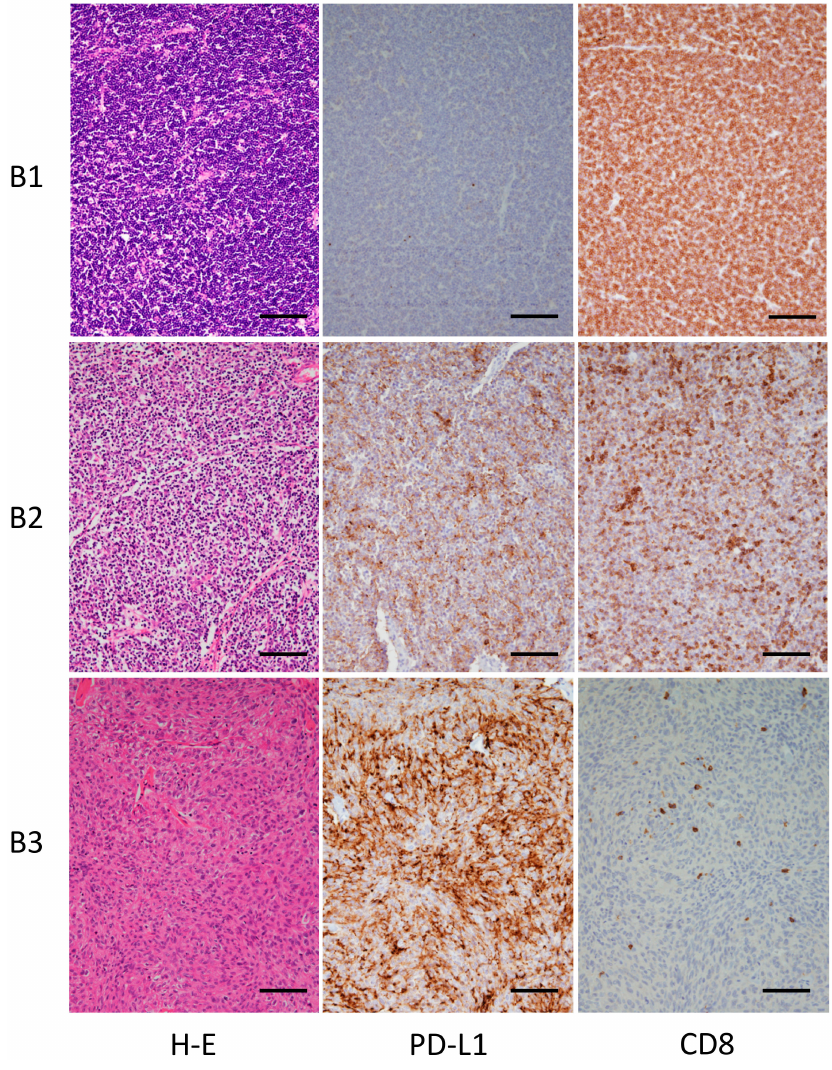
Figure 2. Histological and immunohistological findings for type B thymoma. Representative cases are shown. Type B1 thymoma: Case 21 in Table 1; Type B2 thymoma: Case 23 in Table 1; Type B3 thymoma: Case 31 in Table 1. Original magnification, 100 × ; scale bar, 100 µ m.